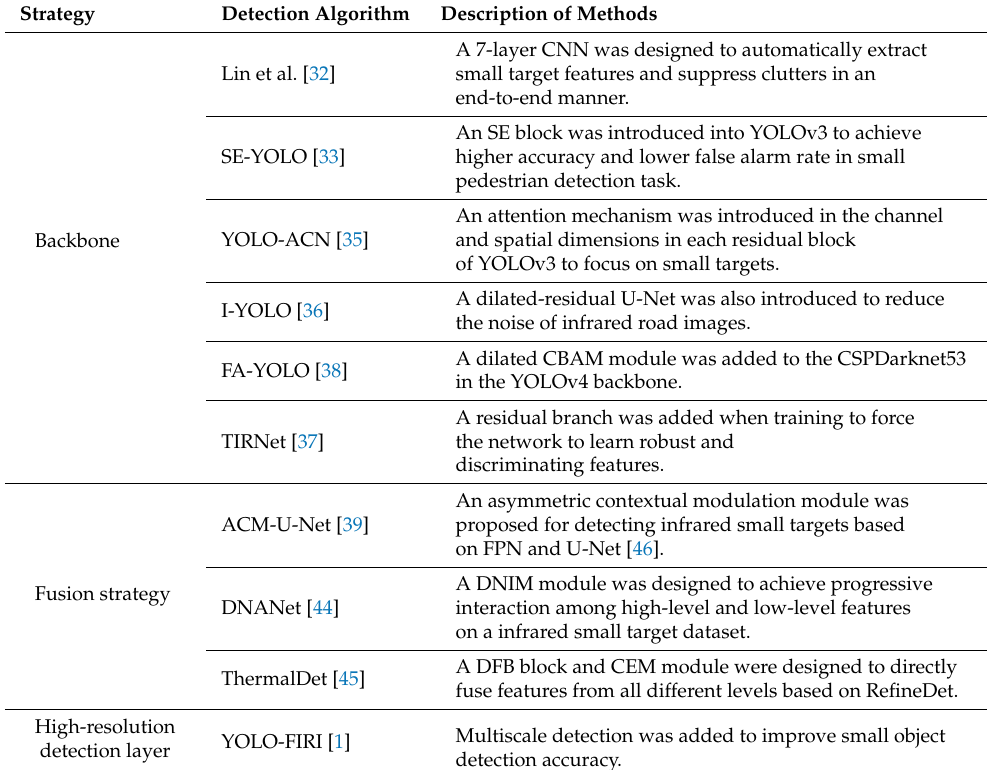
Table 1. Some related works based on deep learning in the field of infrared small target